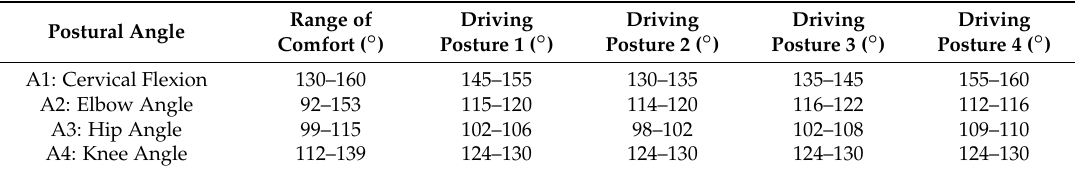
Figure 6. Postural angle model.